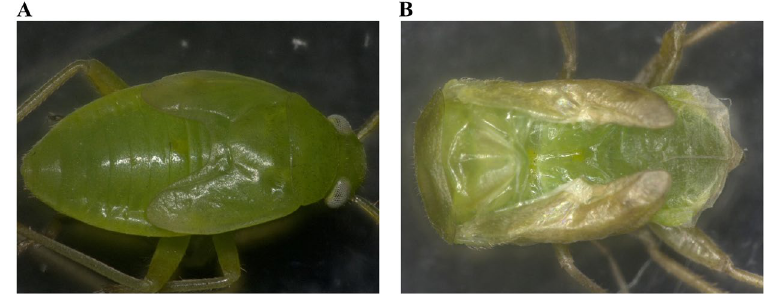
Figure 8. Lethal phenotype produced by injection of ds AlucJHEH . ( A ) Control with non-injection. ( B ) The dead green plant bug with injection of ds AlucJHEH . The nymph exhibited difficulty in molting and dead finally.